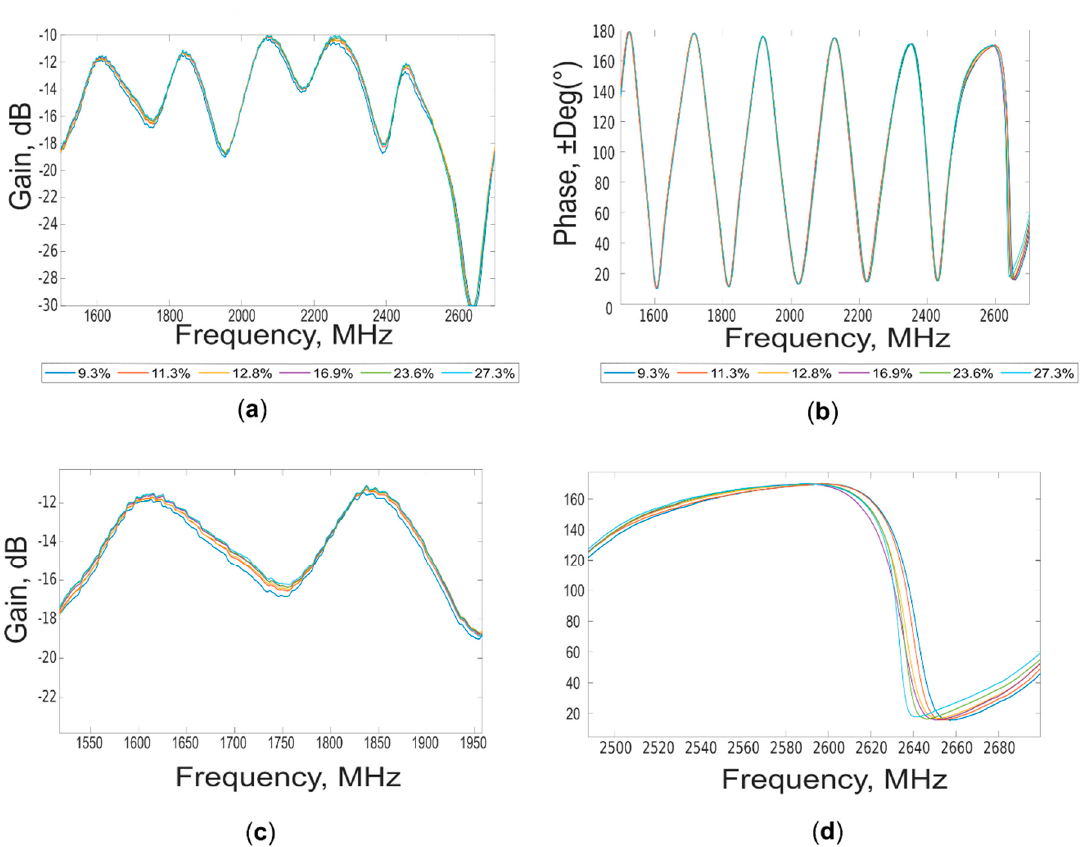
Figure 7. ( a ) “Gain” and ( b ) “phase” waveforms acquired at different moisture content (%). ( c , d ) Magnifications of the waveforms, in the regions where the spectral differences are more pronounced.